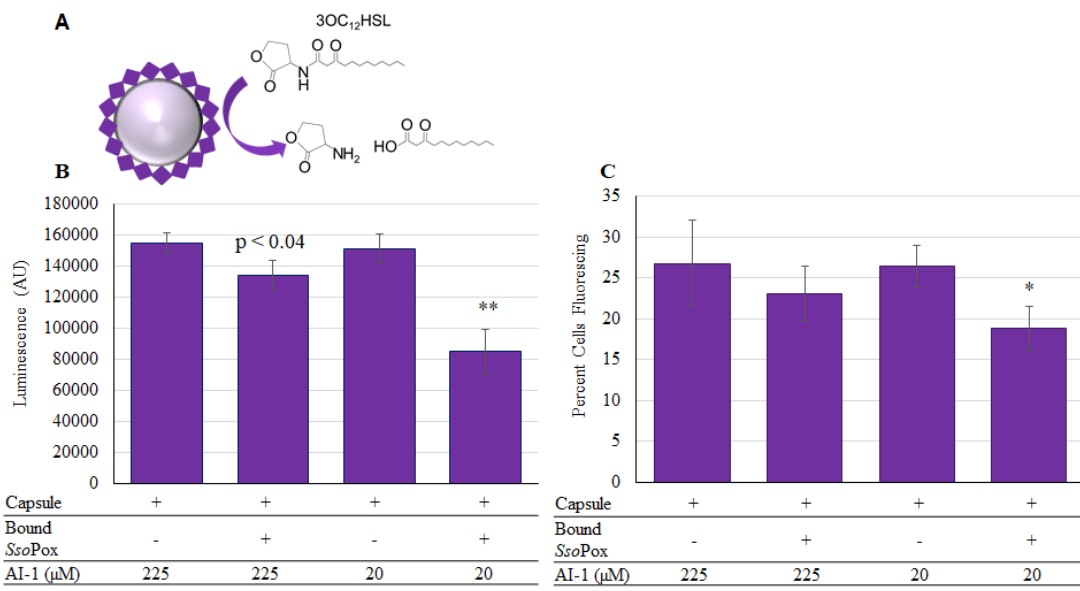
Figure 7. Sso Pox-Gln capsules assembled for AI-1 quenching and activity. In A the reaction in which Sso Pox-Gln hydrolyzes OdDHL is illustrated. In B the luminescent reporter is used to measure remaining AI-1 activity after samples were incubated for 2 h at 37 °C. In C , the same samples were measured with the red-green fluorescent reporter and the chart reflects the percent of cells fluorescing as counted from a total of 50,000 using flow-cytometry. In both charts the bars are the average of three samples with standard deviations provided. P-valu es are calculated by Student’s T -Test, two tails, type 2; * < 0.03, ** < 0.008.